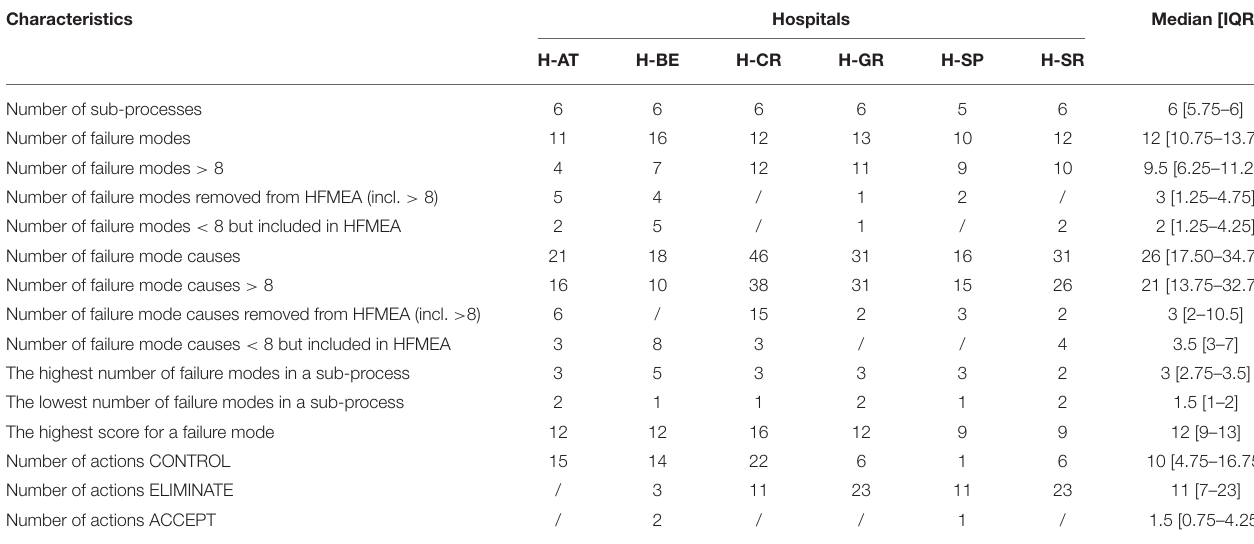
TABLE 2 | Characteristics of hazard analyses between study hospitals. Characteristics